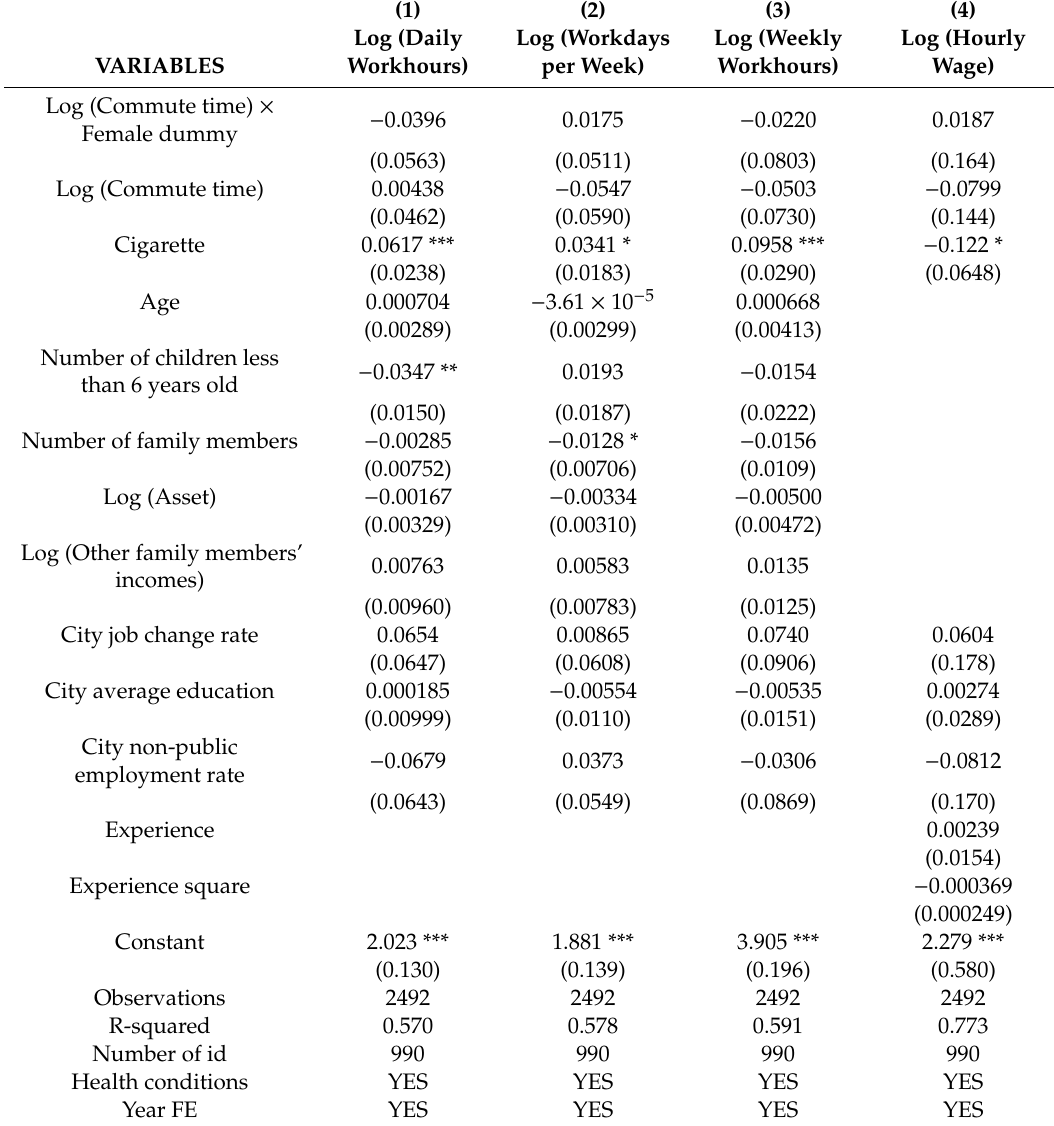
Table 10. Labor supply and wage for job unchanged workers based on